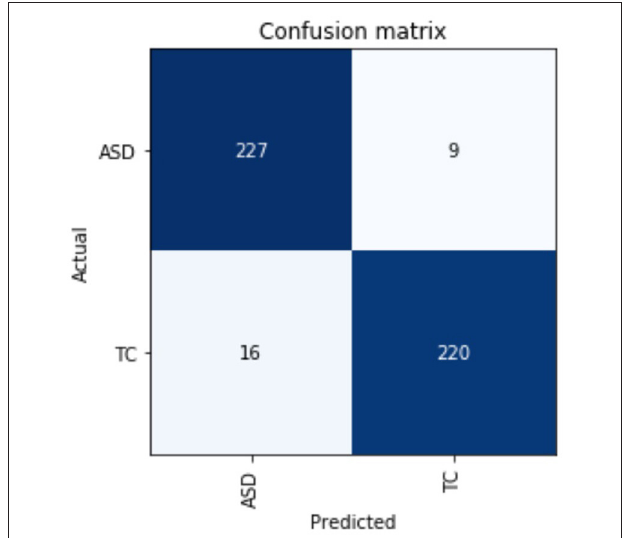
FIGURE 7 | The evaluation performances of confusion metrics.